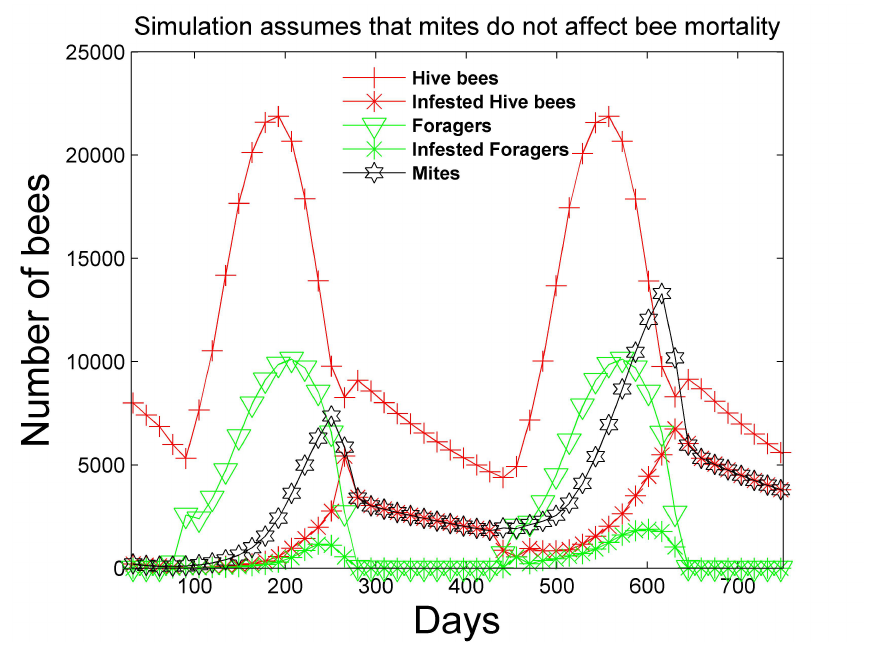
Figure 2. Two-year simulation of a honey bee colony with mites using the simulation parameters in Tables 4 and 5. The number of total hive bees, infested hive bees, total foraging bees, and infested foraging bees is shown. Mites do not affect the survival rate of any bee caste in this simulation. The number of mites closely matches the number of infested hive bees after the summer season ends when one mite remains attached to each infested hive